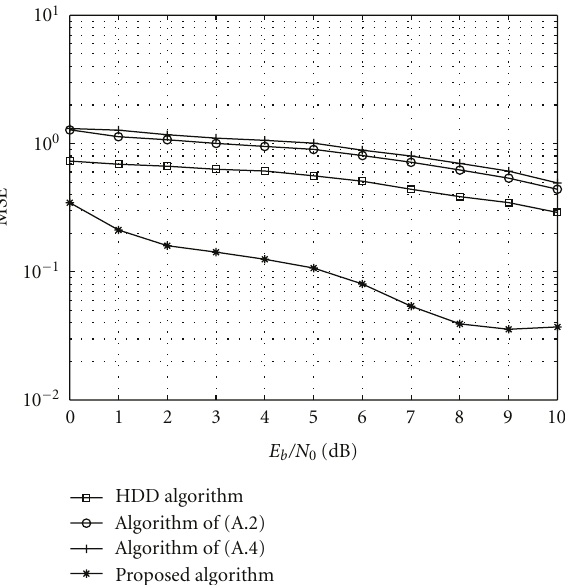
Figure 10: MSE of the phase o ff set estimation obtained after applying the CFO estimation algorithm-BPSK